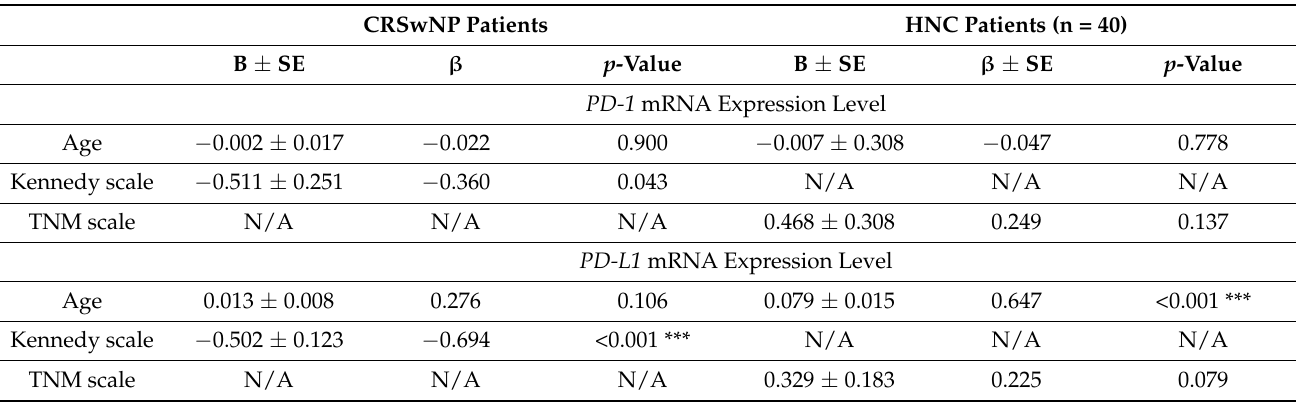
Table 3. Multiple linear regression analysis for age and extent of the diseases on the mRNA expression level of the PD-1 and PD-L1 genes.